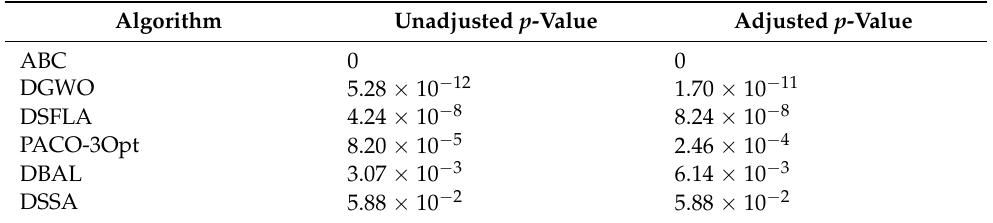
Table 17. p -values by Holm post hoc test (DCPA is the control